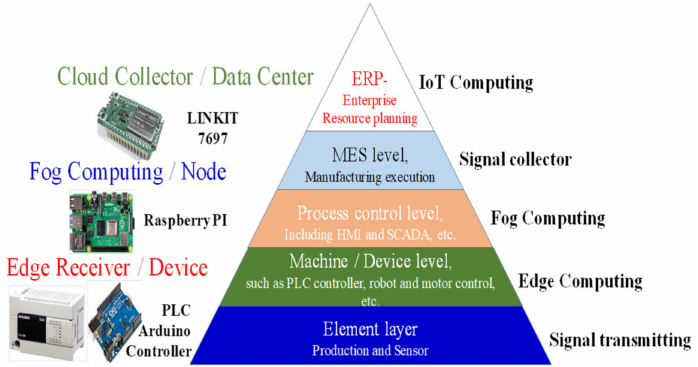
Figure 1. Schematic diagram of IoT smart-factory communication